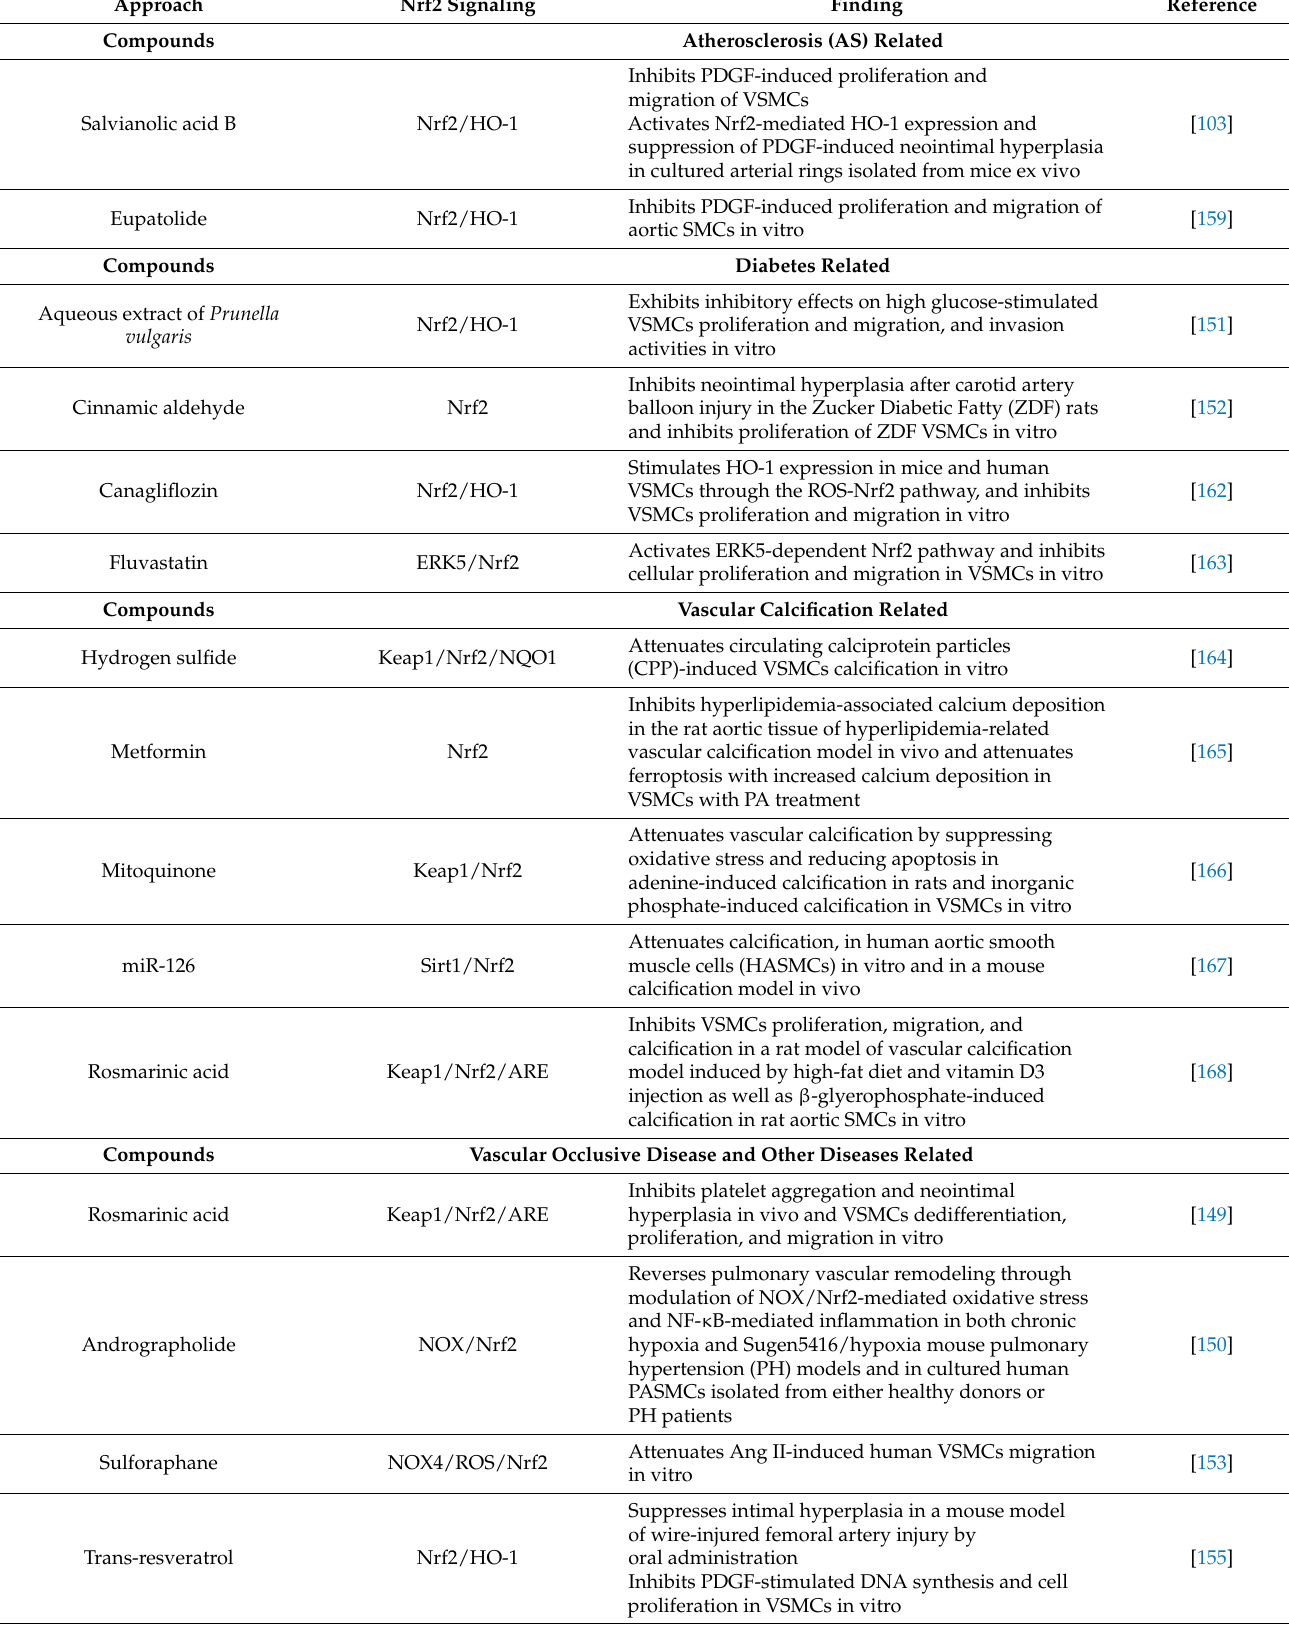
Table 2. Therapeutic targeting Nrf2 signaling for VSMC